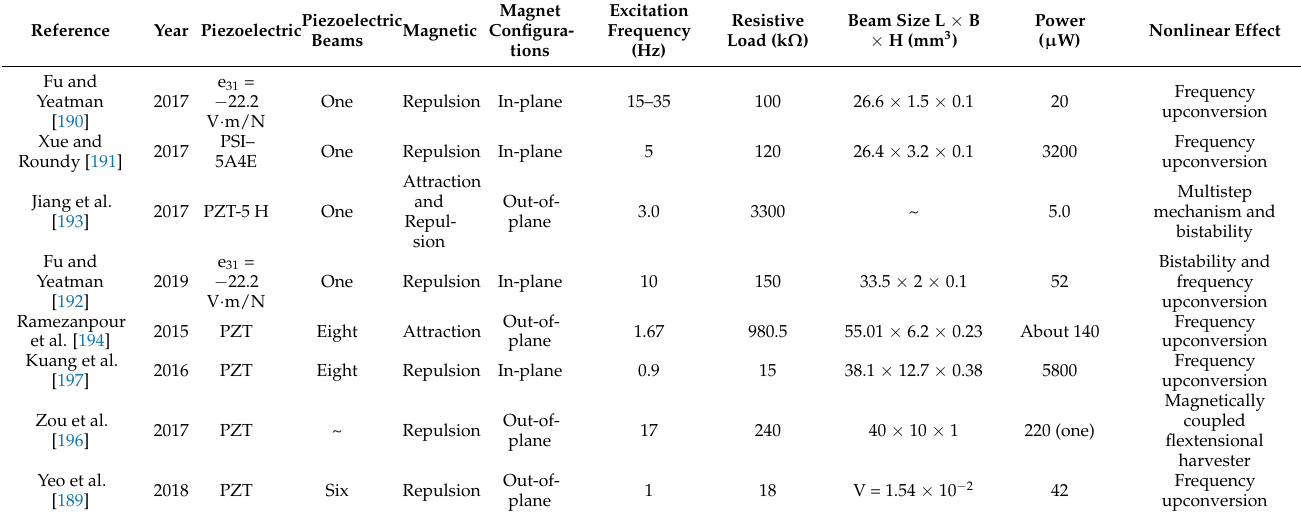
Table 4. Performances of some existing magnetic-plucking-type piezoelectric